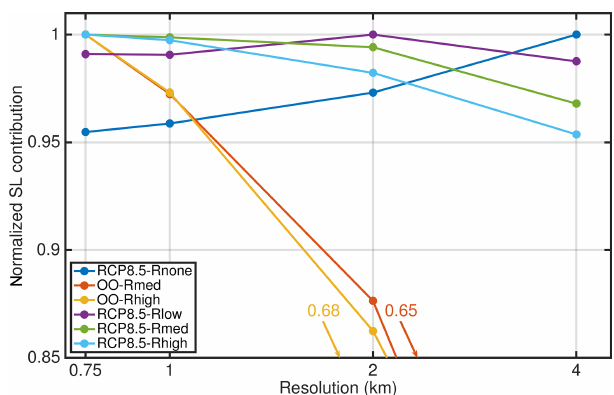
Figure 9. Mass loss partitioning for the conducted experiments. The bars indicate the relative dynamic contribution to sea level, calcu- lated as the residual of the total of the mass change and the inte- grated SMB anomaly. The residual is a composition of front retreat and ice